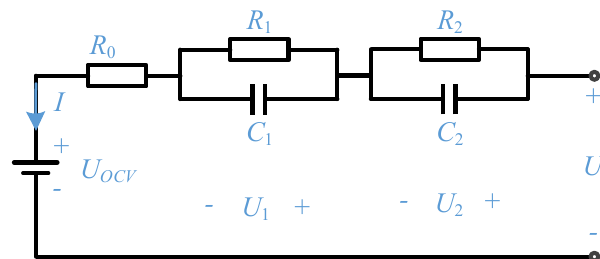
Figure 1. Lithium-ion battery second-order RC circuit